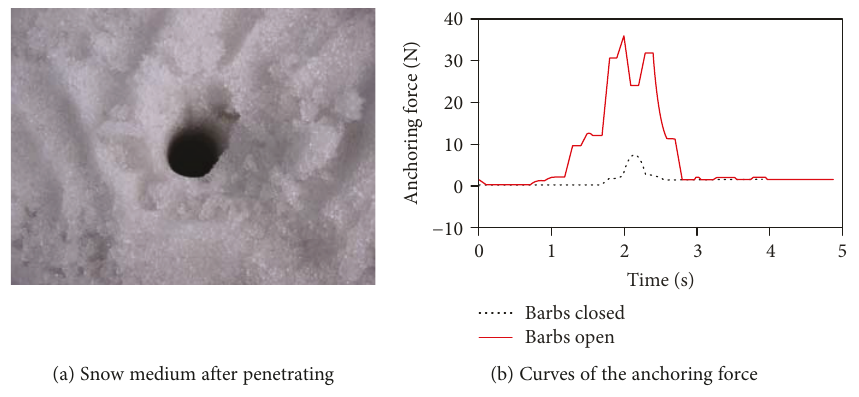
Figure 16: Penetrating and anchoring tests in snow medium.